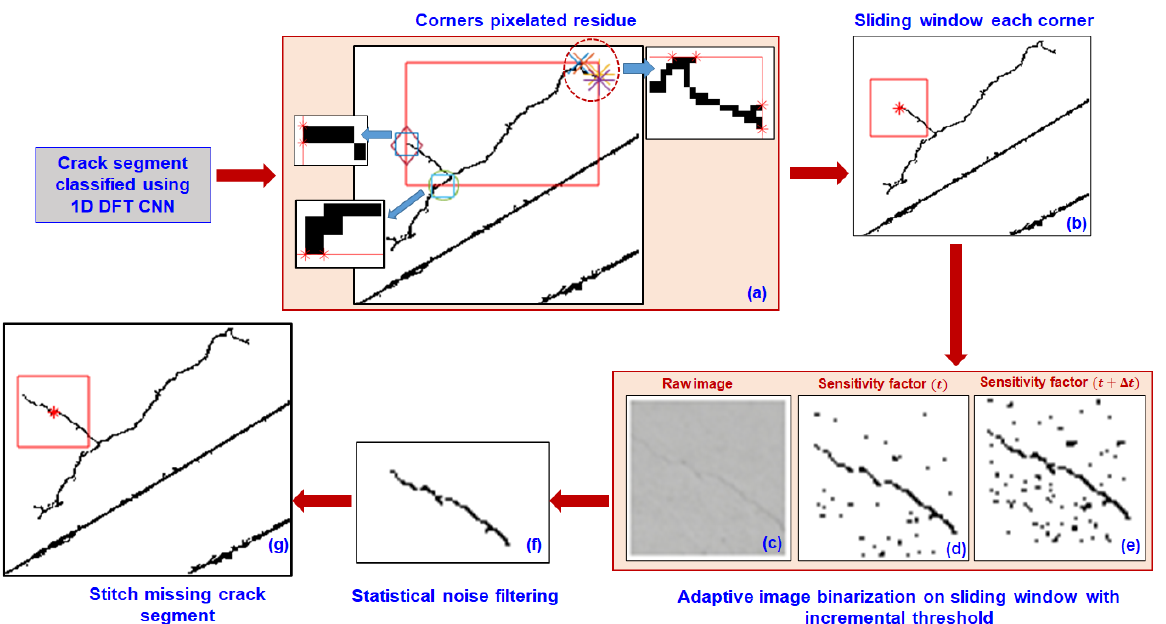
Figure 4. Algorithm for 1D DL-assisted image processing for identification of thin propagating cracks post DL-based crack and non-crack classification. ( a ) Identify endpoints of pixelated residue in the crack segments that the 1D DFT-CNN model classifies (markers indicates the endpoints of pixelated residue; red color rectangle is the bounds of the pixelated residue; circle indicates region of zoom window). ( b ) Define sliding window (red color square) with each endpoint (red star marker) as the centroid of the window. ( c ) Map and extract the corresponding sliding window in the raw image. Adaptive integral binarization on sliding window with ( d ) original sensitivity factor ( t ) and ( e ) differential sensitivity factor ( t + ∆ t ) . ( f ) Filtered sliding window using geometric properties of crack. ( g ) Stitch sliding window in pixelated image to connect missing segments of